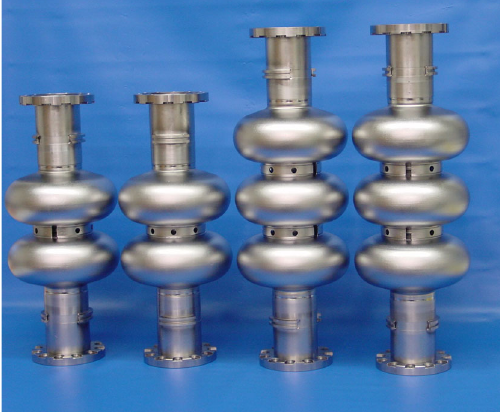
FIG. 31. Two- and three-cell cavities hydroformed at DESY.